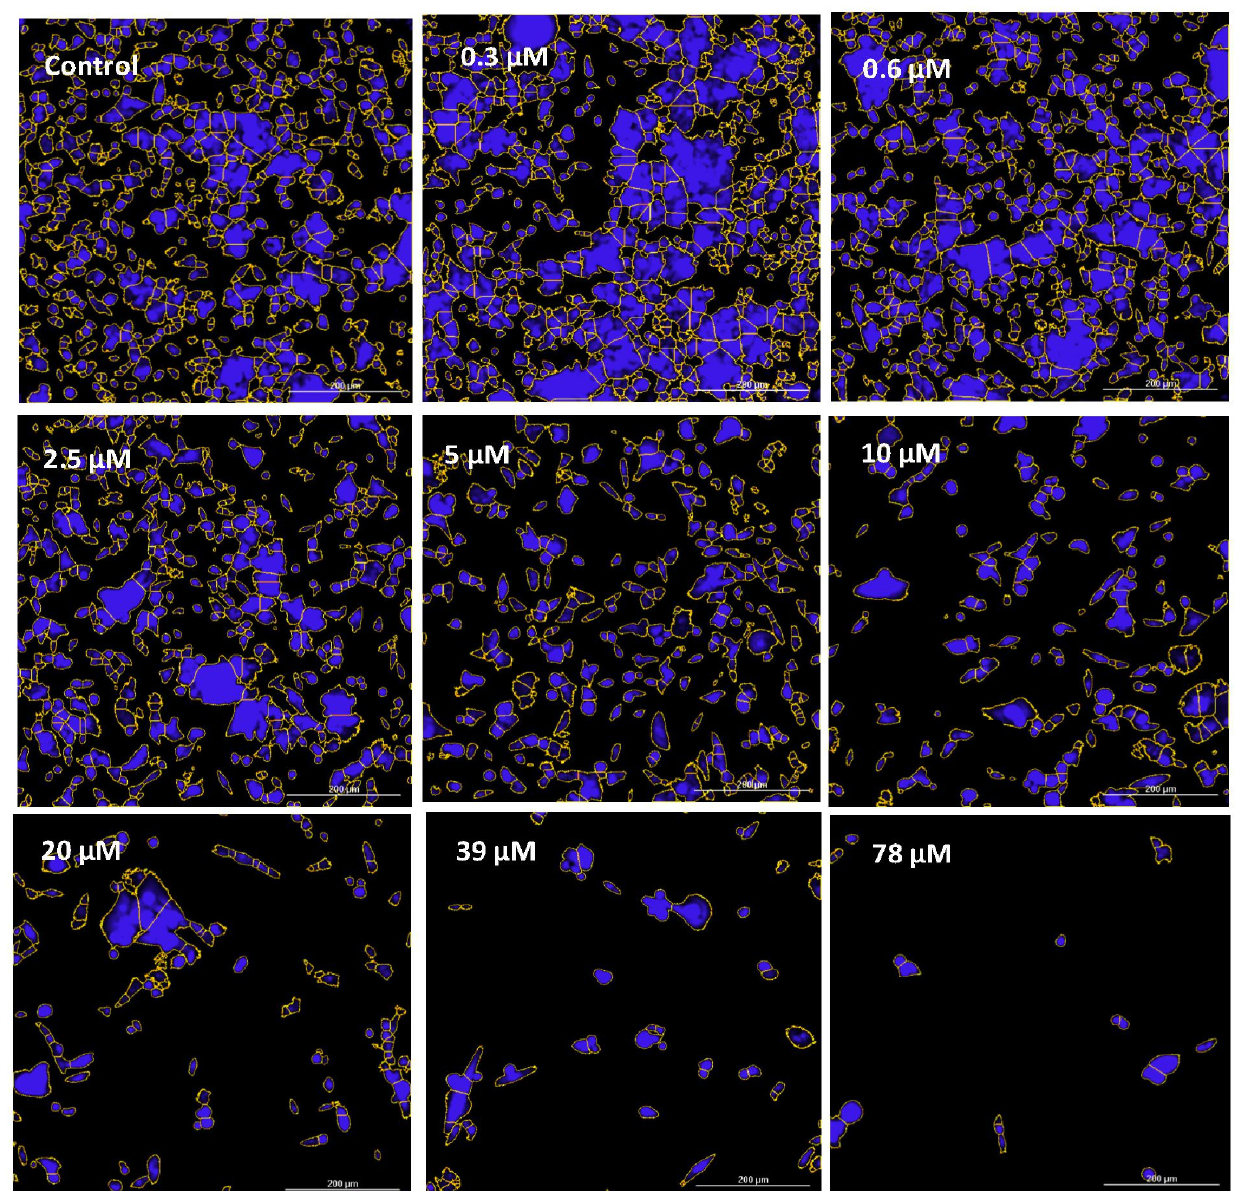
Figure 3. Cytostatic effects of GNE-140 in MDA-MB-231 cells after a 7 day proliferation period. Images represent nuclear cell count in viable cells using DAPI staining, with cell count analytical masking (yellow outline) established with the Biotek Cytation 5 Analytical Imaging System (Winooski, VT, USA). The images corroborate the cytostatic properties of the drug, as shown in Figure 2B, using Alamar Blue detection agent for cell counting.